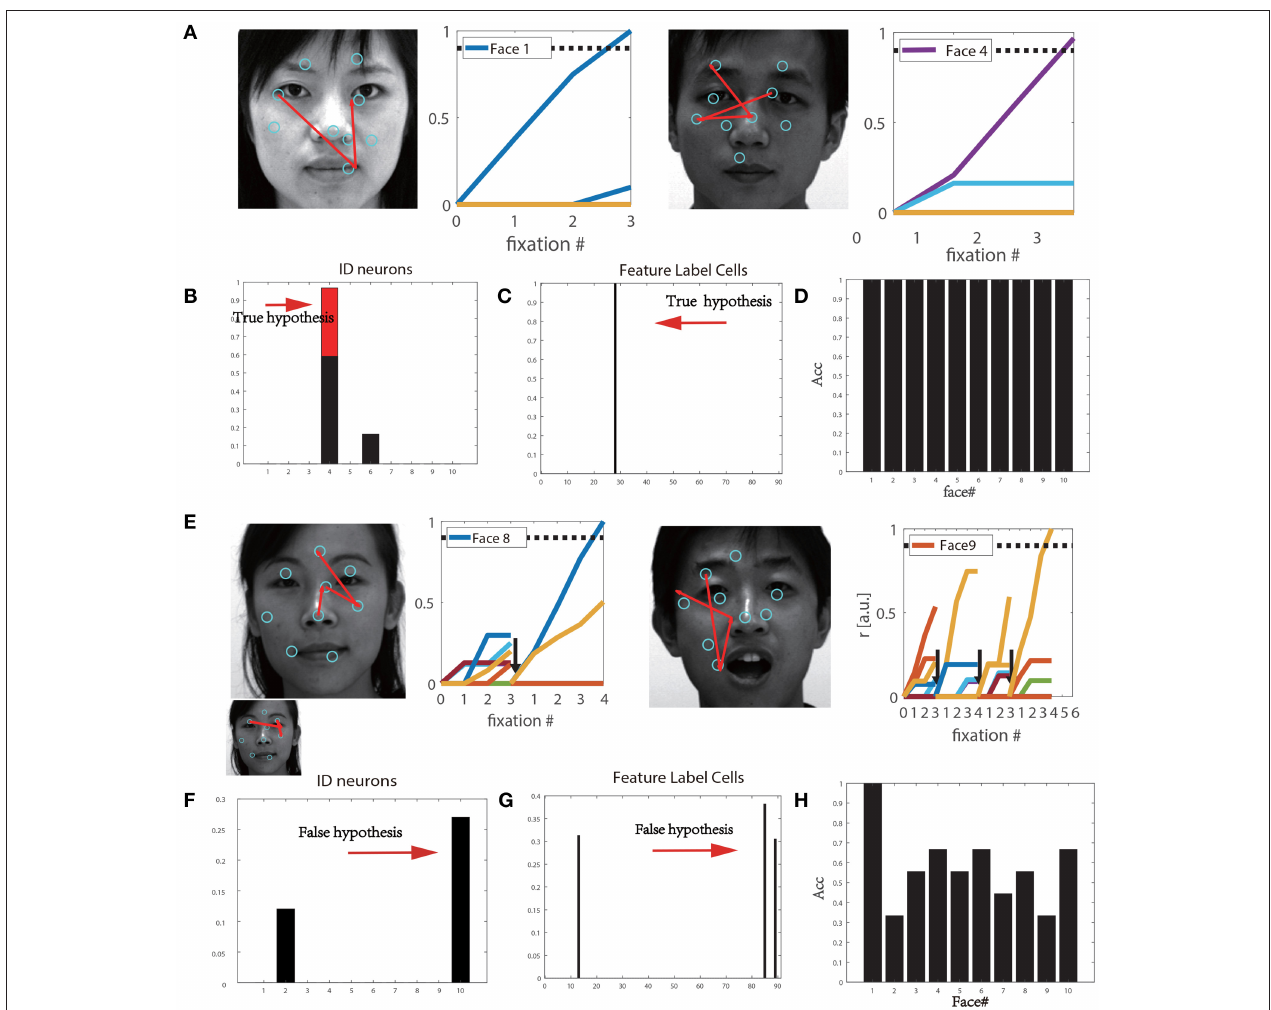
FIGURE 3 | (A) Continuous saccades during training. (B) The firing rate of identity cells based on true hypothesis. (C) The activation rate of feature label cells based on true hypothesis. (D) Recognition accuracy for 10 individual types from the training set. (E) Continuous saccades on the test faces. (F) The false firing rate of the identity cells based on the false hypothesis. (G) The true firing rate of the feature label cells based on false hypothesis. (H) Recognition accuracy for 10 individual faces from the testset.